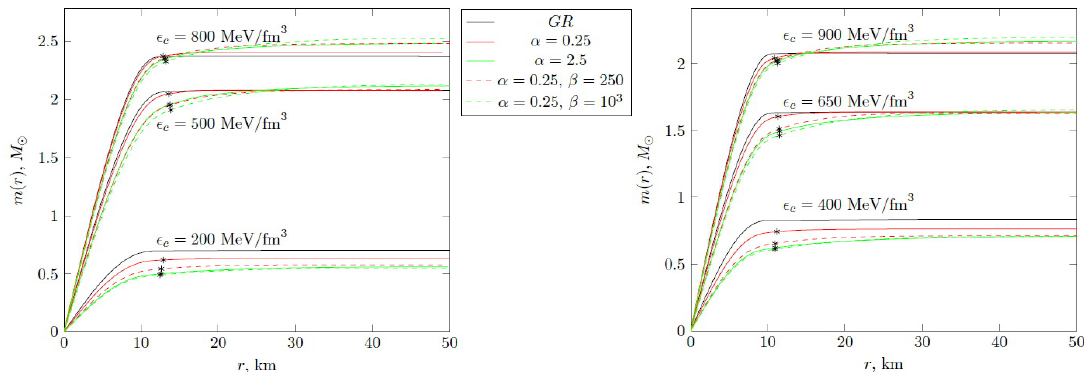
Figure 2. Mass profiles for some central densities using EoS GM1 (left panel) and APR (right panel) for some values of α and β in comparison with general relativity. Asterisks hereinafter designate points for which (cid:101) = p = 0 (surface of